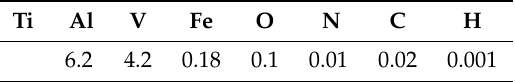
Table 2. Chemical composition of Ti6Al4V